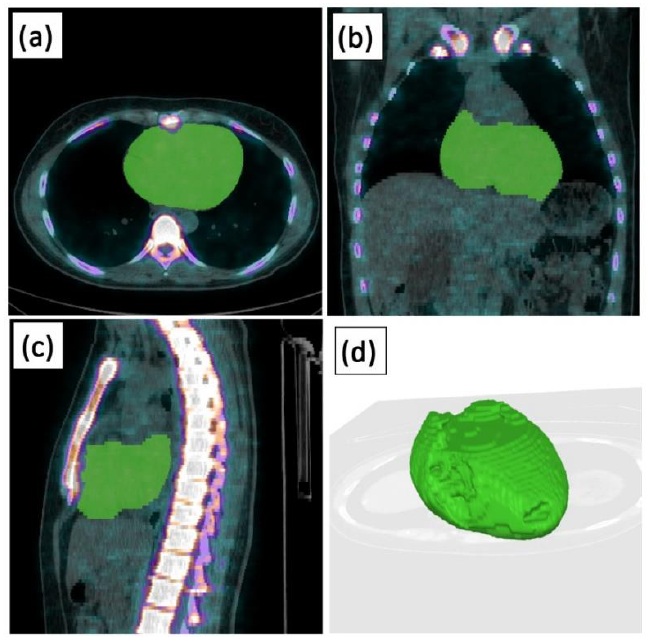
Figure 1. Axial ( a ), coronal ( b ), and sagittal ( c ) reconstruction of AI-based cardiac segmentation in the same patient and 2D representation of the 3D reconstructed heart using AI ( d ).